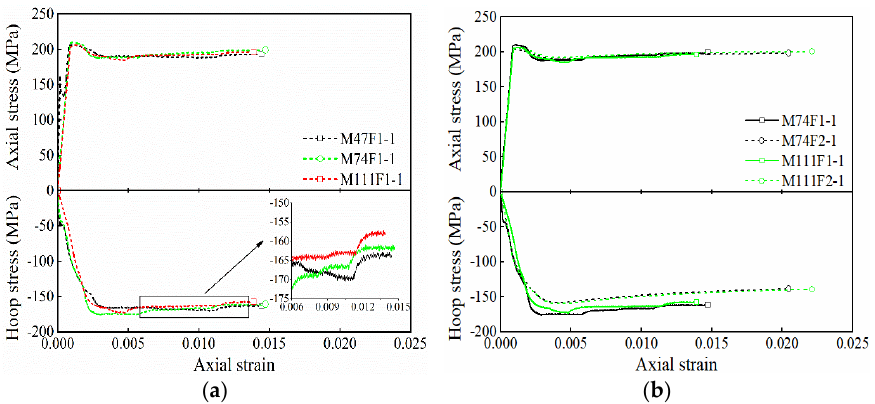
Figure 11. Typical axial strain–bidirectional stress curves for steel tube: ( a ) influence of relative di- ameter ratio; ( b ) influence of confinement strength. diameter ratio; ( b ) influence of confinement